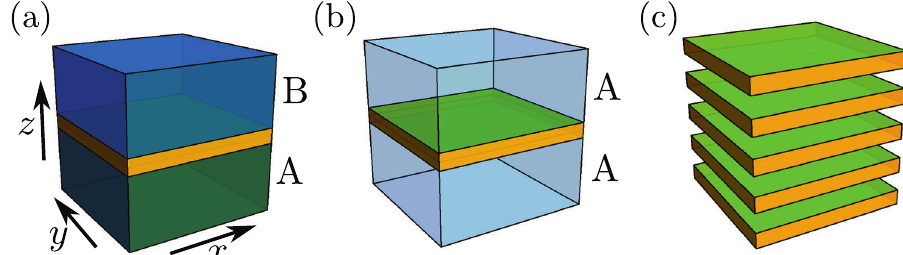
Fig. 1 From a symmetry point of view, 2D systems ( yellow ) can be grouped into those realized in an asymmetric ( a ) or symmetric ( b ) environment. Layered materials consisting of weakly coupled sheets as shown in ( c ) are not included in our de fi nition of 2D systems